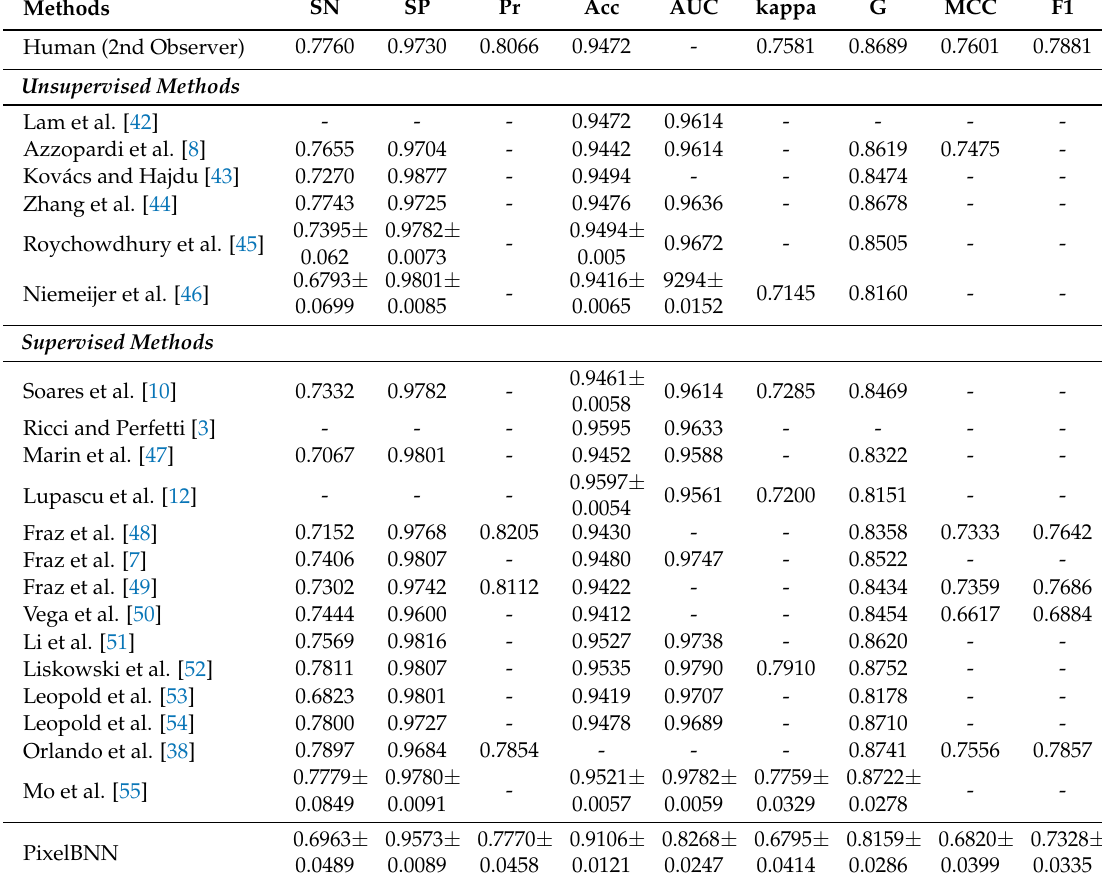
Table 3. Performance comparison for models trained and tested with